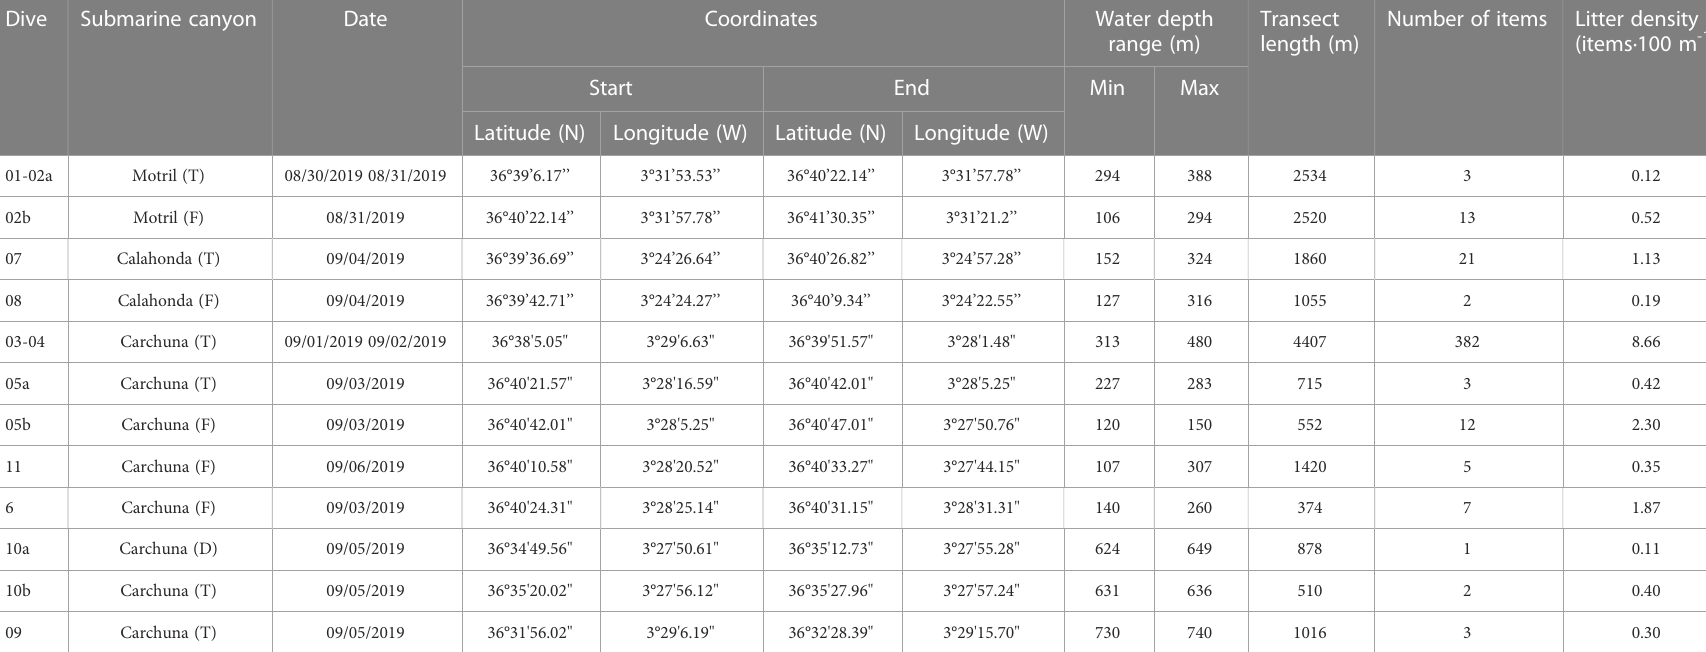
TABLE 1 Summary of ROV dives used in this study including their water depth range, length, the amount of litter detected, and litter density recorded in each dive.